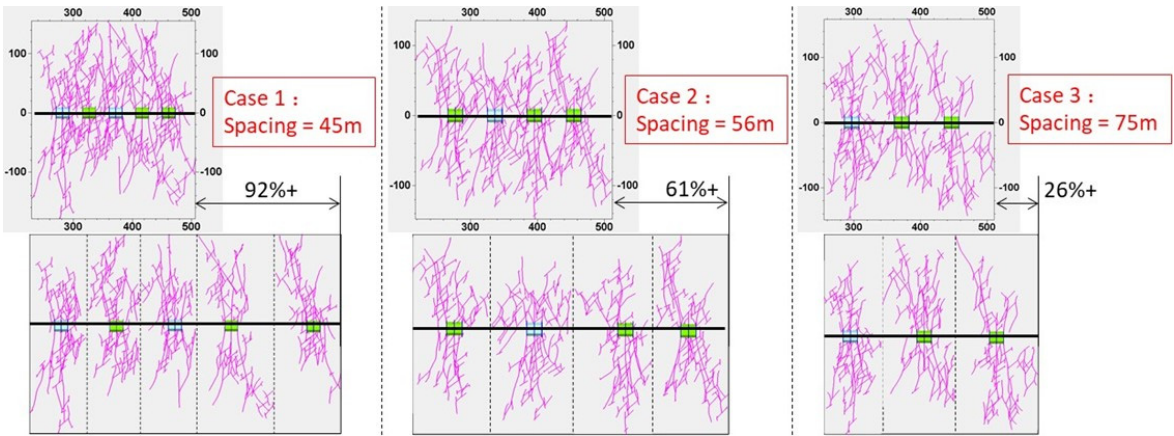
Figure 8. Complex fracture configuration under different stage spacing (global scale vs. individual scale).